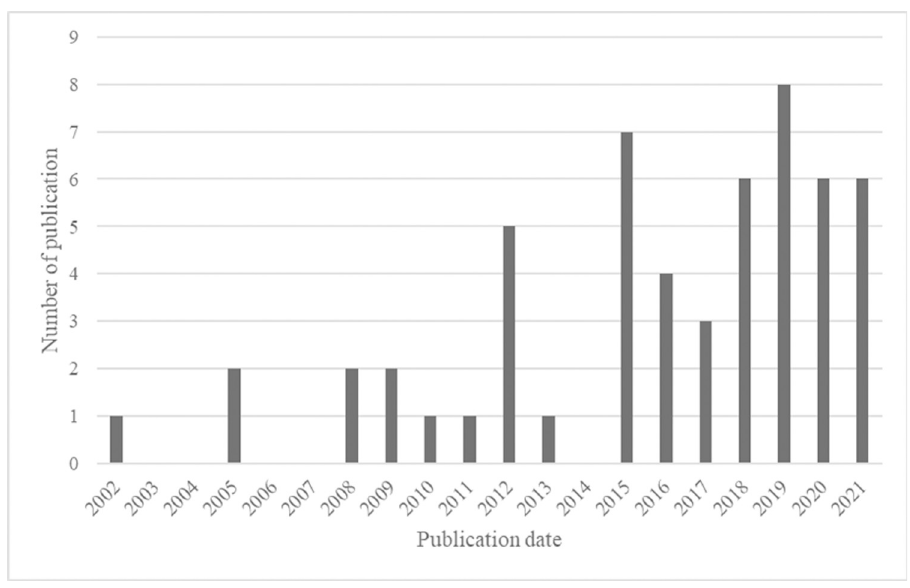
Fig 2. Distribution of articles by publication date.